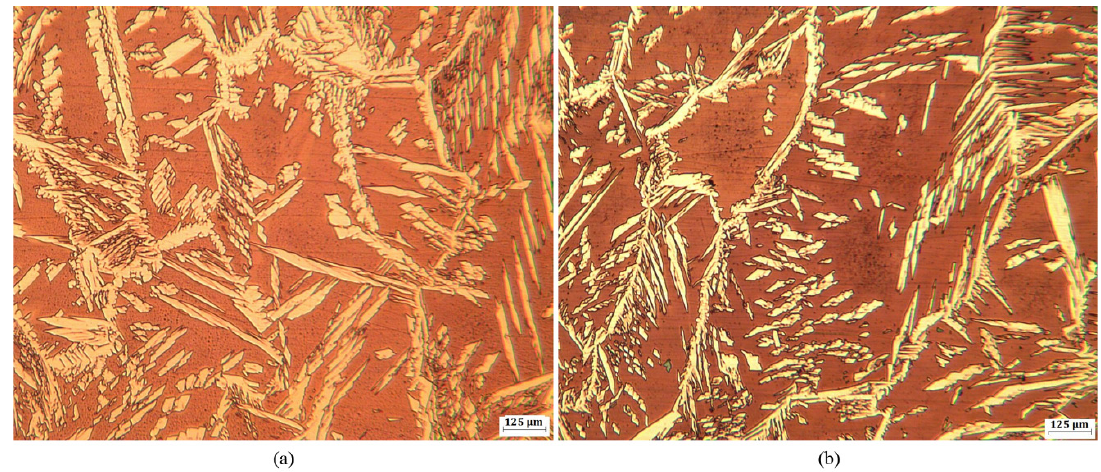
Figure 18. Microstructure from the 2205 DSS FZ: (a) shielding gas A (b) shielding gas B. (0.6 kJ mm –1 ).